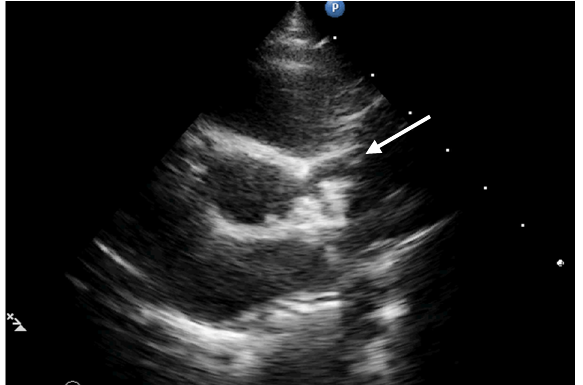
Figure 2. Parasternal long axis. Dilation of a vascular structure into the atrioventricular groove (circumflex artery: white arrow).